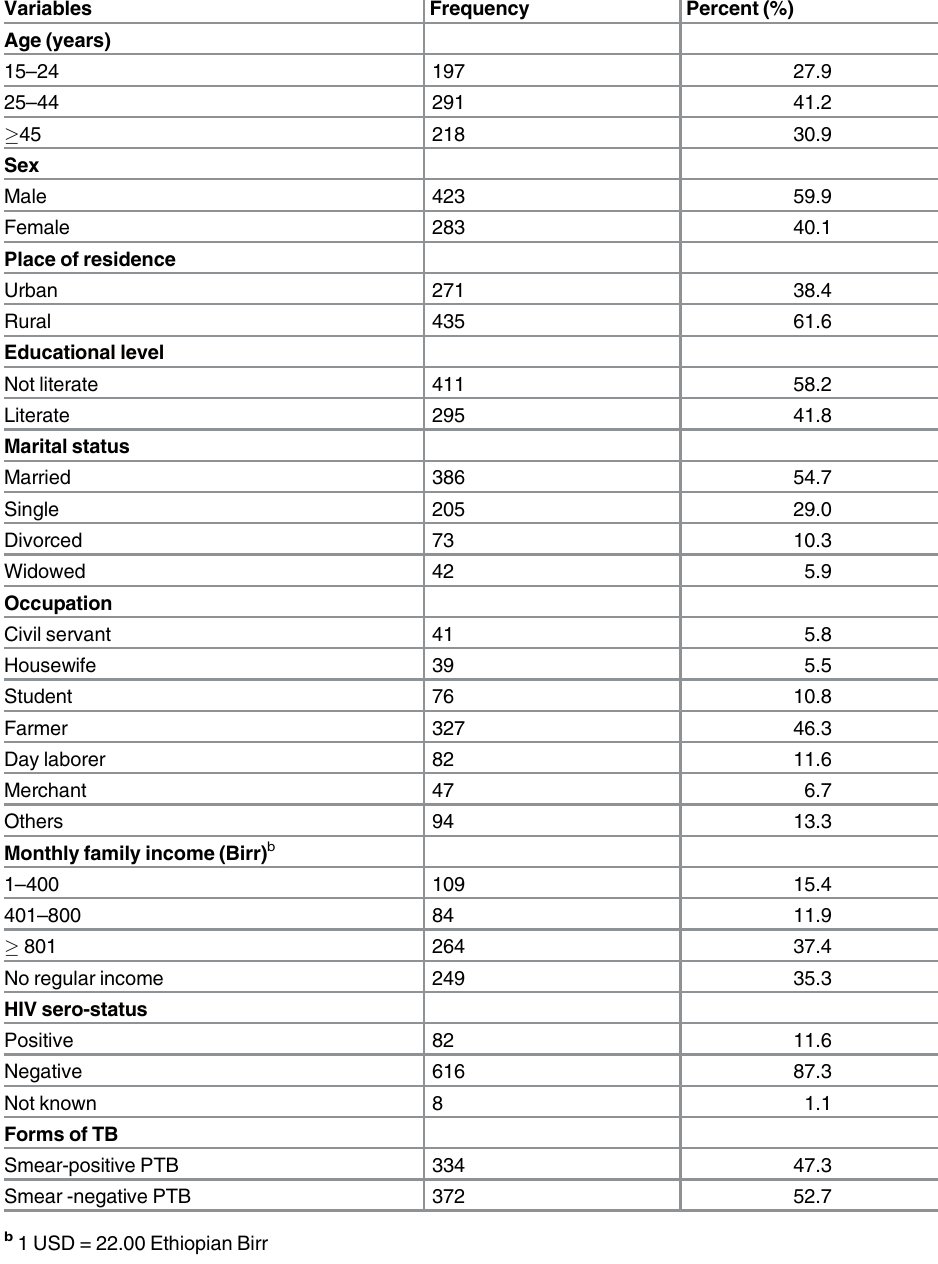
between total delay and death of PTB patients. Of the 28 patients who died during TB treat- ment, 18 (64.3%) patients had a total delay of > 60 days, and 27 patients did know their HIV status of which 13 (48.1%) were coinfected with HIV. Of the 13 HIV coinfected PTB patients who died during treatment, 11(84.6%) had total delay of more than 60 days. Nineteen (67.8%)